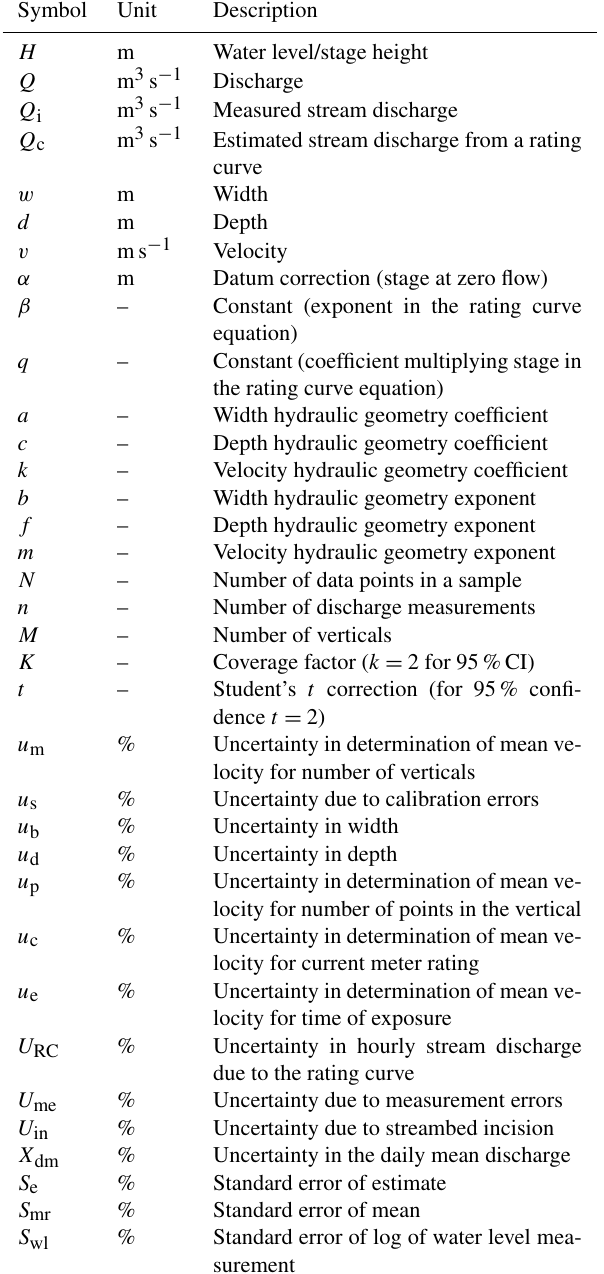
Table A1. Nomenclature used in this paper. Symbol Unit